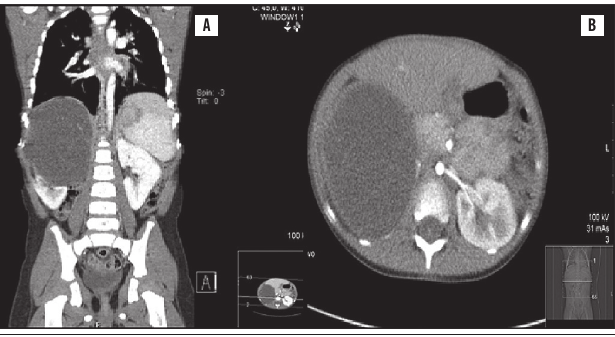
figurE 1 − CT scan showing a hypodense and multilocular lesion, which is well-defined, capsulated and expansive, located in the upper pole of the right kidney CT: computed tomography.